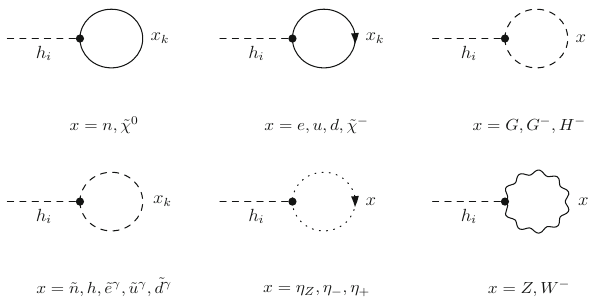
Fig. 2 GenericFeynmandiagramscontributingtotheone-looptadpole counterterms. The index k is given by k = 1 ,..., 18 for x = ˜ n , k = 1 ,..., 5 for x = h ,χ 0 , k = 1 ,..., 9 for x = n and k = 1 ,..., 3 for x = e , u , d , ˜ e , ˜ u , ˜ d . The index γ denotes the left- and right-handed scalars. Color indices for the quarks and squarks are